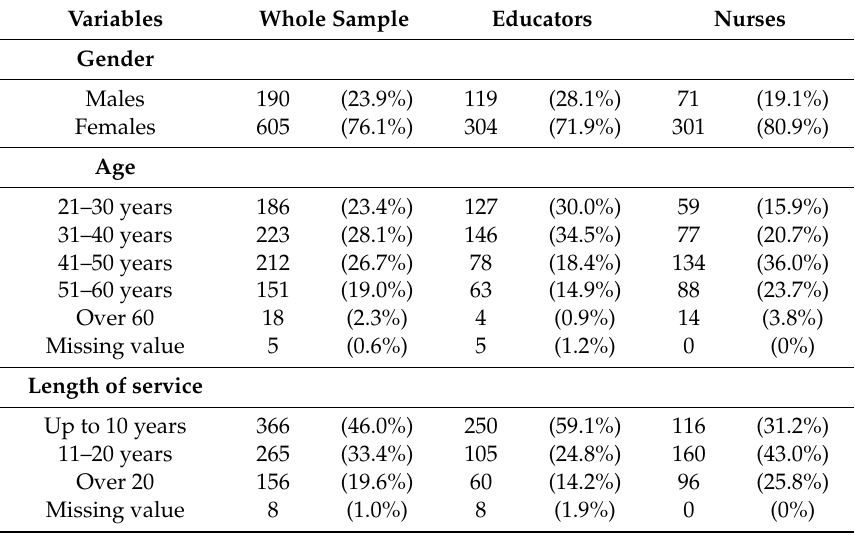
Table 1. Participant